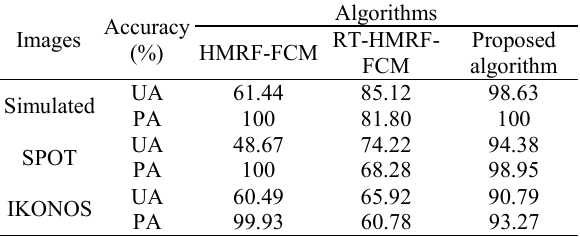
Table 1. Quantitative